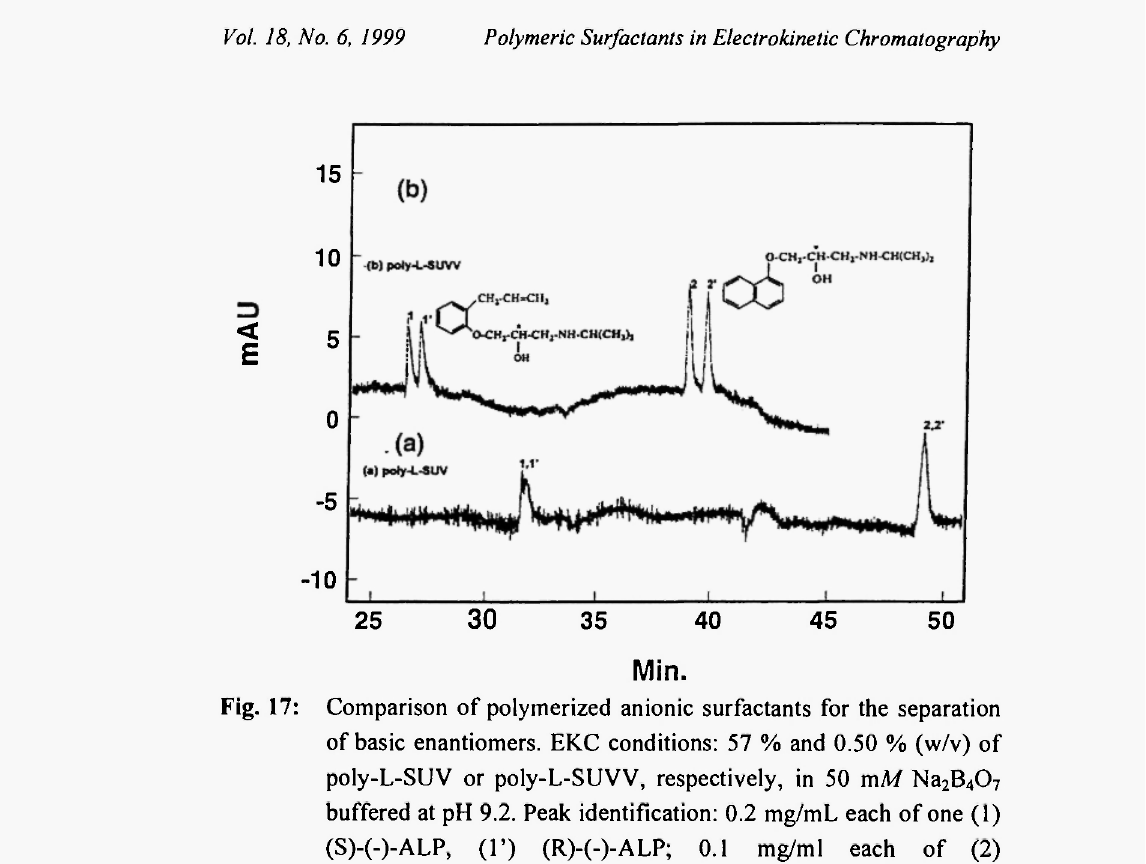
Fig. 17: Comparison of polymerized anionic surfactants for the separation of basic enantiomers. EKC conditions: 57 % and 0.50 % (w/v) of poly-L-SUV or poly-L-SUVV, respectively, in 50 mΜ Na 2 B 4 0 7 buffered at pH 9.2. Peak identification: 0.2 mg/mL each of one (1) (SM-)-ALP, (Γ) (R)-(-)-ALP; 0.1 mg/ml each of (2) (S)-(-)-PROP, (2') (R)-(+)-PROP. Pressure injection for 2 s; +20 kV applied for separation; current, 85 μΜ for for poly-L-SUV and 56 μΑ for poly-L-SUVV. UV detection was at 214 nm. From /58/ with